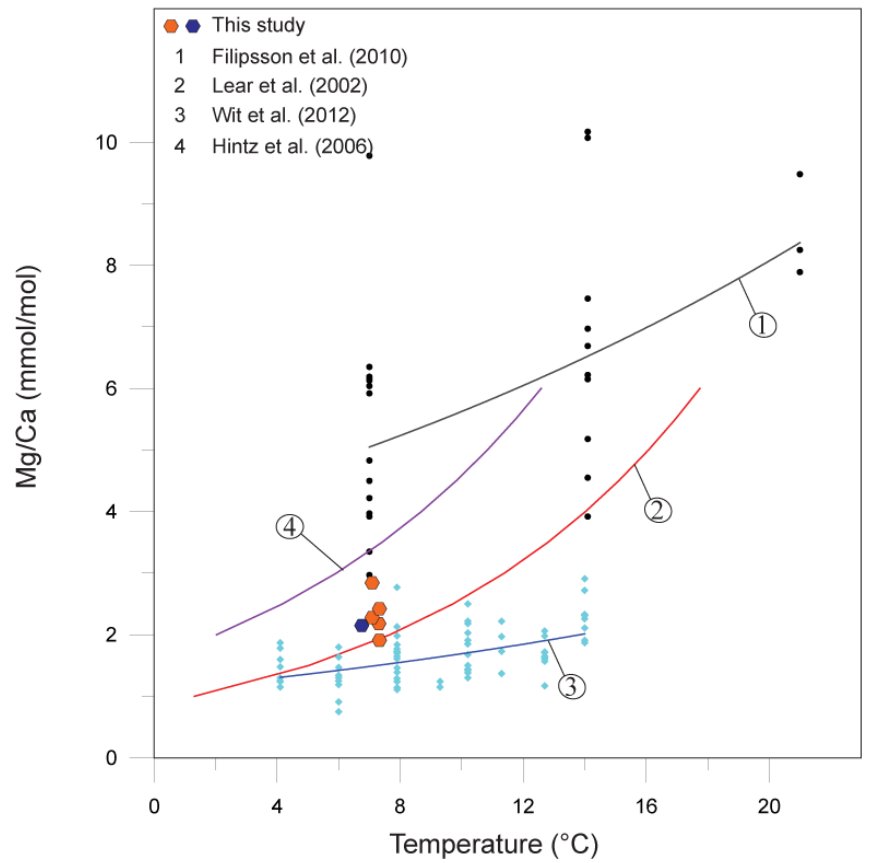
Fig. 3a. Mg/Ca vs. temperature for B. marginata from this study (hexagons: orange (Skagerrak), blue (Gullmar Fjord)) in comparison with published data for B. marginata/aculeata (Filipsson et al., 2010; “1”), multiple species (Lear et al., 2002; “2”); B. marginata (Wit et al., 2012; “3”), and B. marginata (Hintz et al., 2006a; “4”). Single measurements of Filipsson et al. (2010) and Wit et al. (2012) were included to show the scatter when laser ablation is used on single specimens/chambers in comparison with our bulk measurements. Note that the results of the lowest temperature experiment of Filipsson et al. (2010) are omitted from the figure. Error bars are too small to be displayed (see Methods